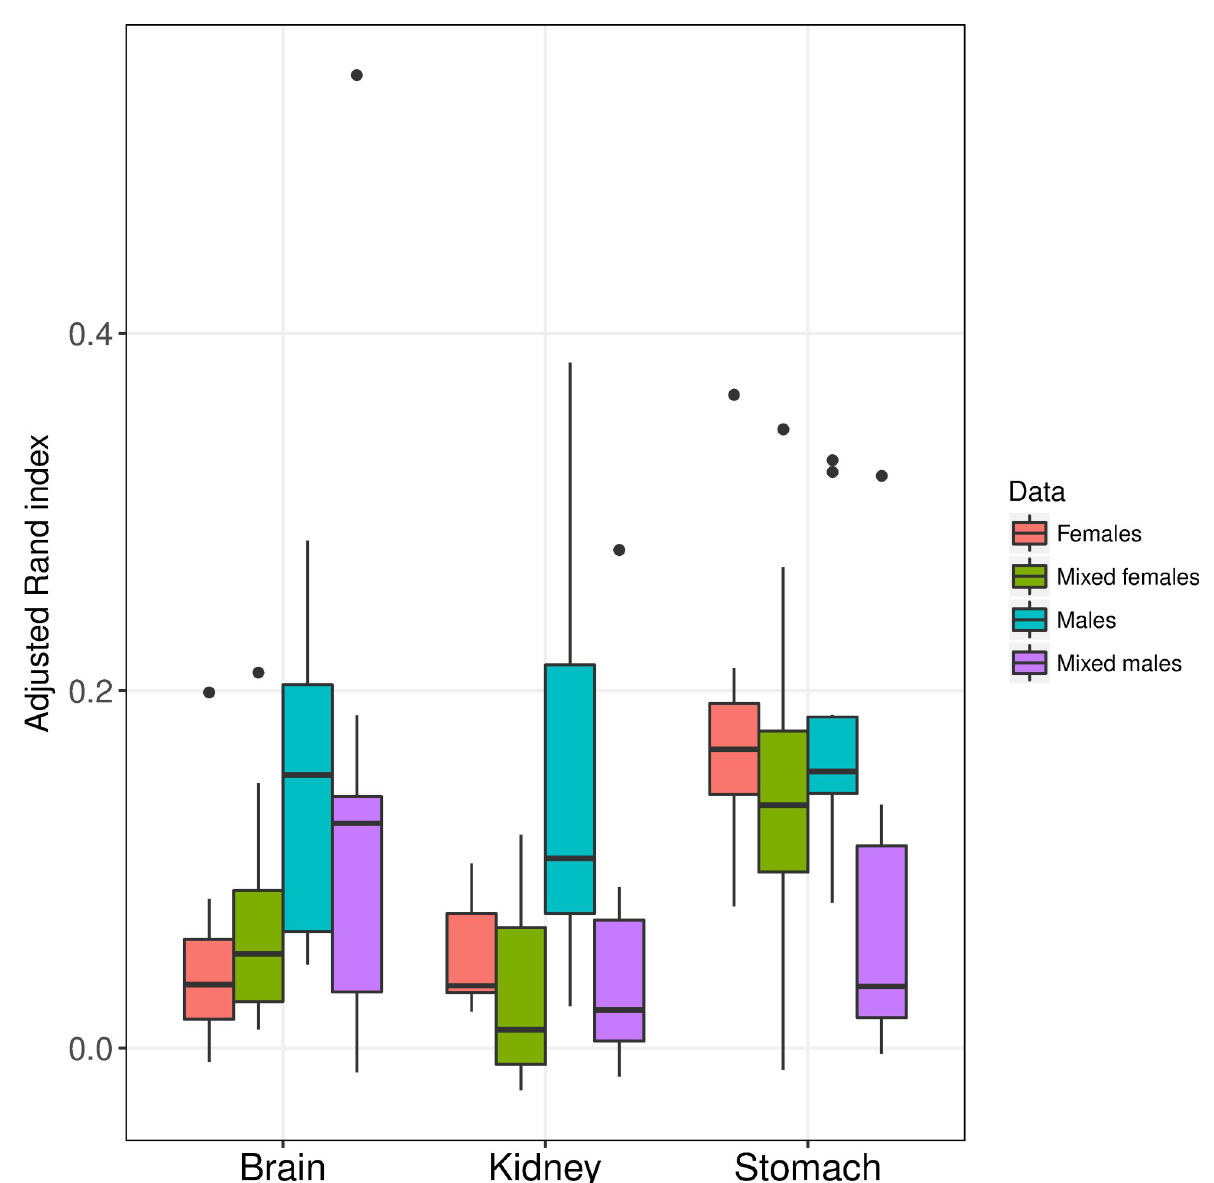
Fig 6. Gender difference. Adjusted Rand index for Brain, Kidney and Stomach when dividing samples by gender. All data sets had a symmetric distribution (i.e. 50% of each subtype).